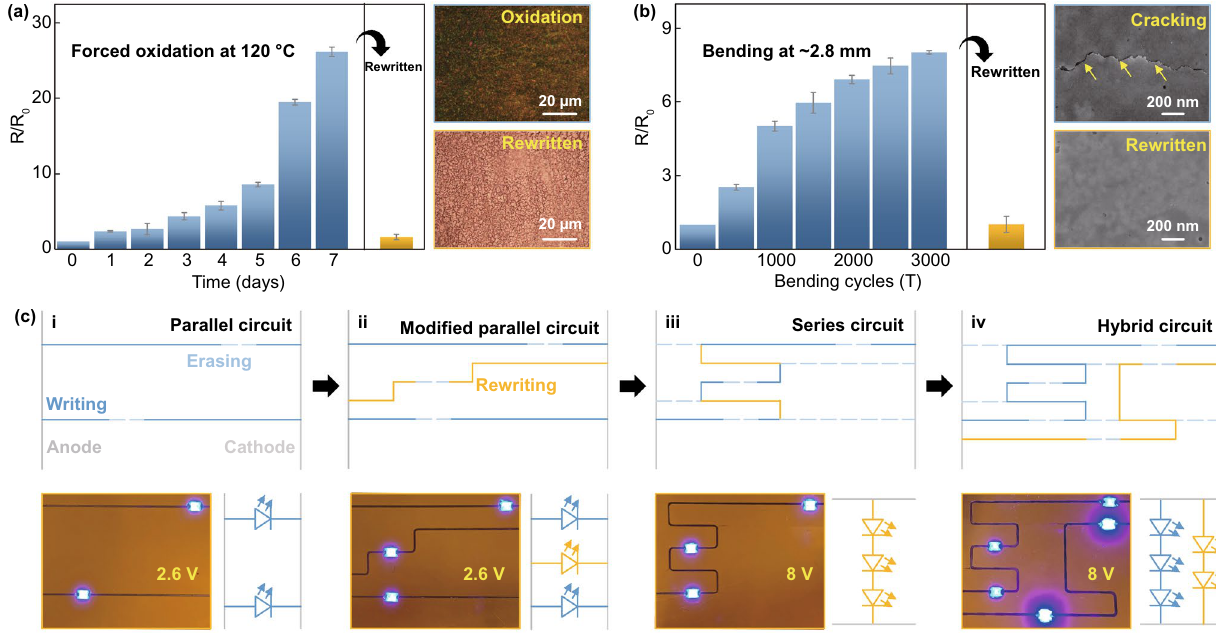
Fig. 5 Demonstration of erasable laser writing for repairing and reprogramming circuits. Relative resistance changes of the patterns during a enforced oxidation process, b bending process, and after rewriting. Insets are the surface morphologies of the pattern, respectively, correspond- ing to the state after oxidation, bending, and rewriting. c Schematics of pattern changes and their corresponding actual digital images for the reprogrammed circuits. The subsequent circuits are gradual modifications from the first case but on different PI substrates. LEDs are introduced after finishing these circuits to confirm they are